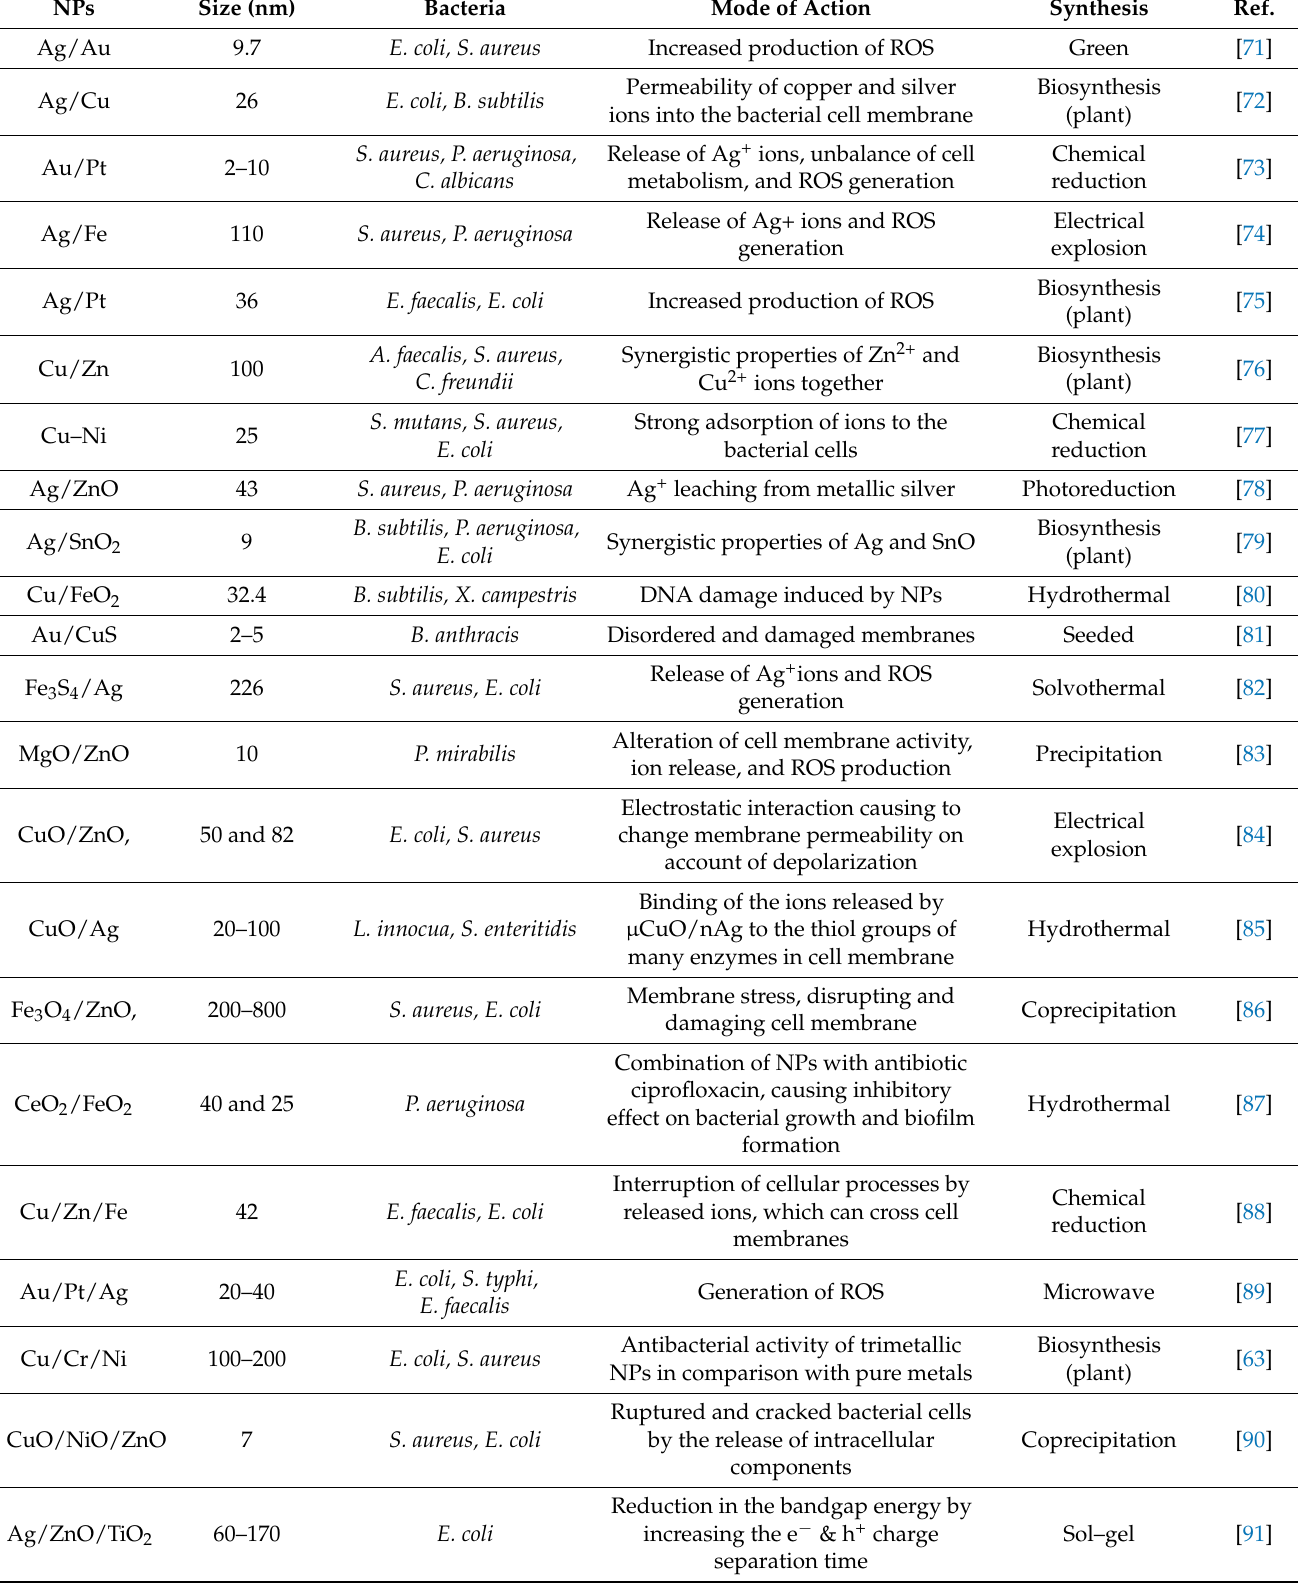
Table 2. Antimicrobial activity of bimetallic and trimetallic